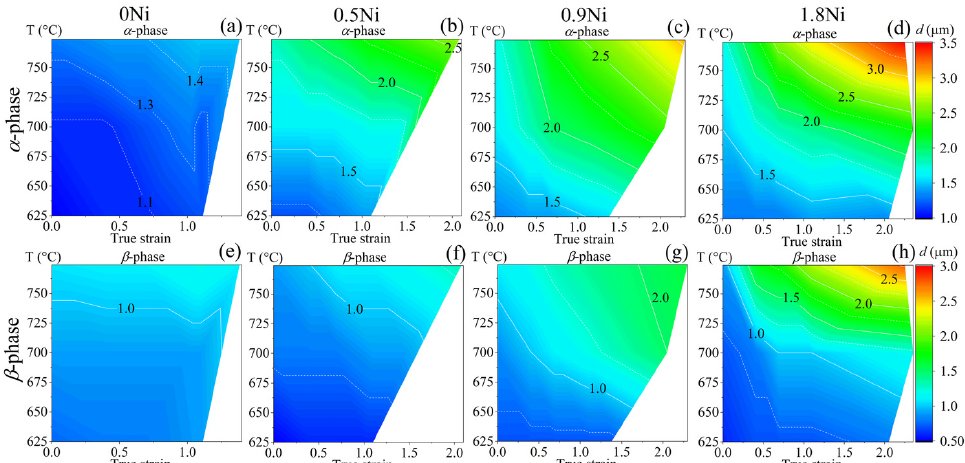
Figure 10. Grain size evolution of the ( a – d ) α and ( e – h ) β phases vs. true strain of ( a , e ) 0Ni, ( b , f ) 0.5Ni, ( c , g ) 0.9Ni, and ( d , h ) 1.8Ni alloys during deformation at 1 × 10 − 3 s − 1 and temperature range of 625–775 °C.